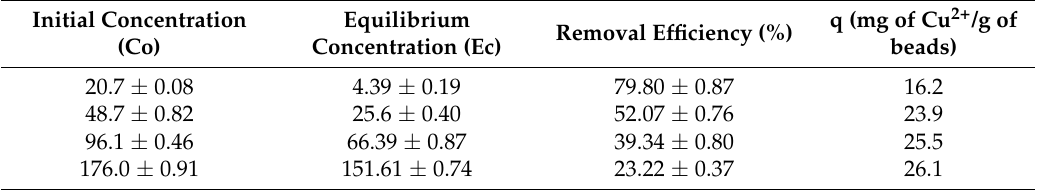
Table 2. Adsorption of Cu 2+ into cross-linked chitosan composites with biomass, alginate, and TPP. Initial